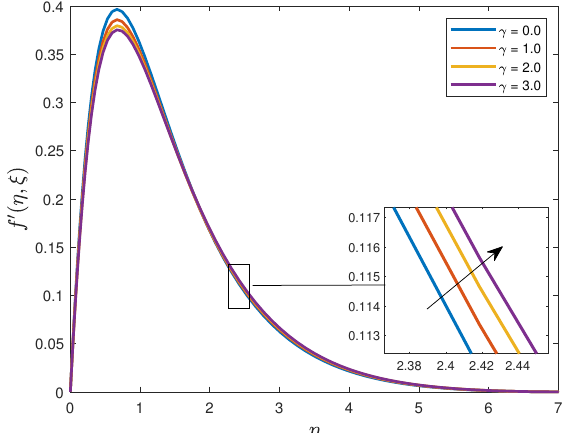
Figure 19. The influence of γ on fluid